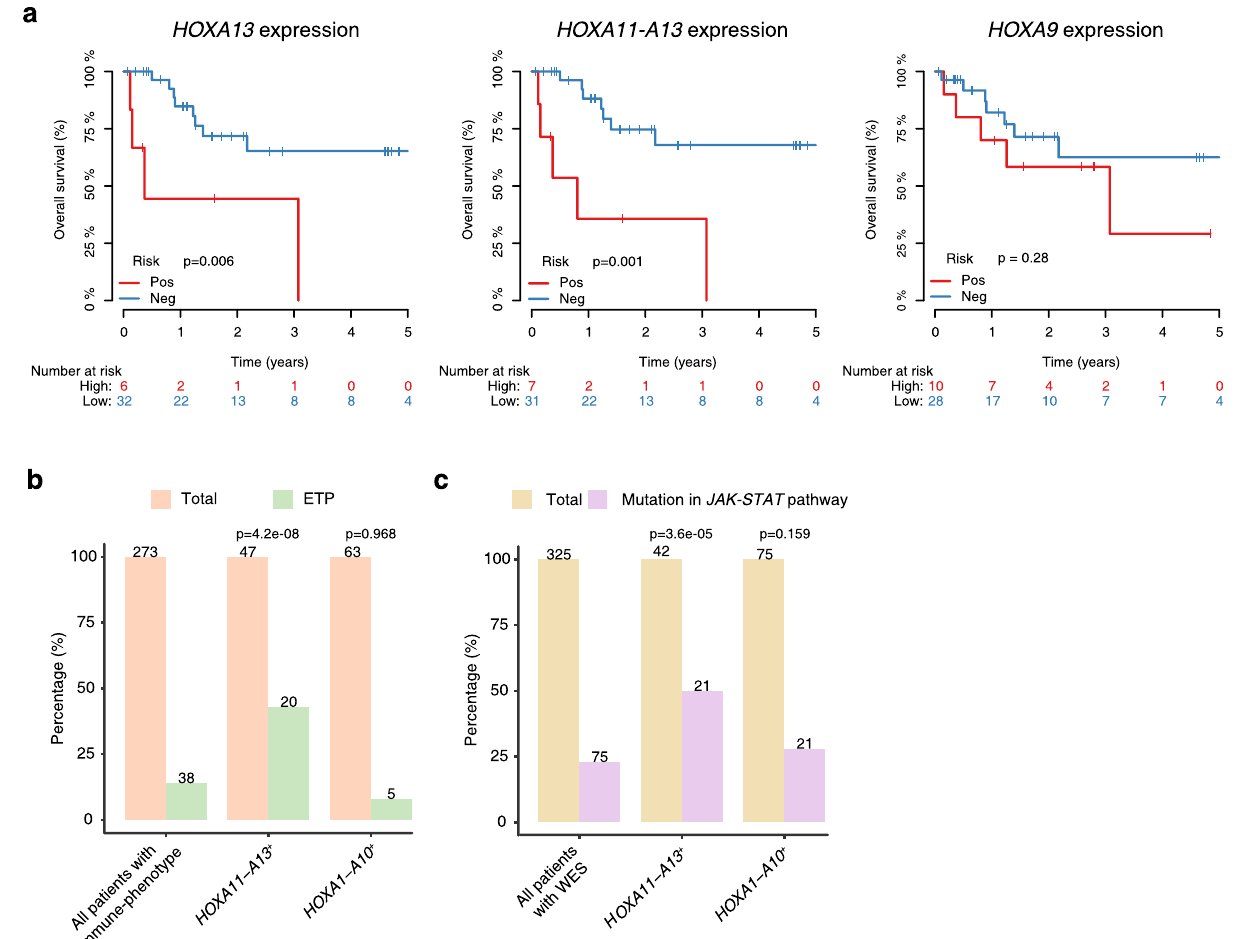
Fig. 6 Ectopic HOXA11 - A13 expressions are correlated with poor outcomes in pediatric and young adult T-ALLs. a Kaplan – Meier overall survival curves for patients with (red) and without (blue) ectopic HOXA13 expression (left), HOXA11-A13 expressions (middle) and HOXA9 expressions (right) in pediatric and young adult patients. P values are based on the two-sided log-rank test. b The associations between ectopic HOXA11-A13 expression and ETP phenotypes. P values are calculated by the one-sided Fisher exact test. c The proportion of cases with JAK-STAT pathway mutations in each T-ALL subgroup, P values are calculated by the one-sided Fisher exact